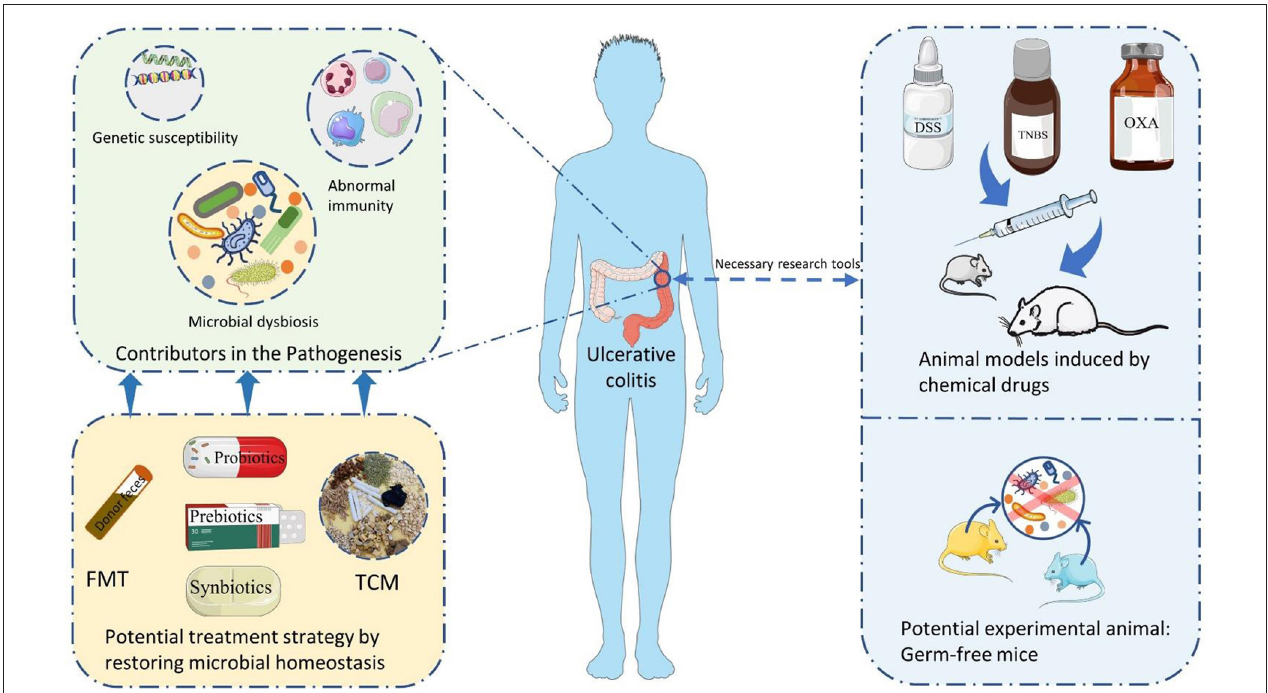
FIGURE 1 | The summary of themes in this review. FMT, Fecal microbiota transplantation; TCM, traditional Chinese medicine; DSS, dextran sulfate sodium; TNBS, 2,4,6-trinitrobenzene sulfonic acid; OXA,